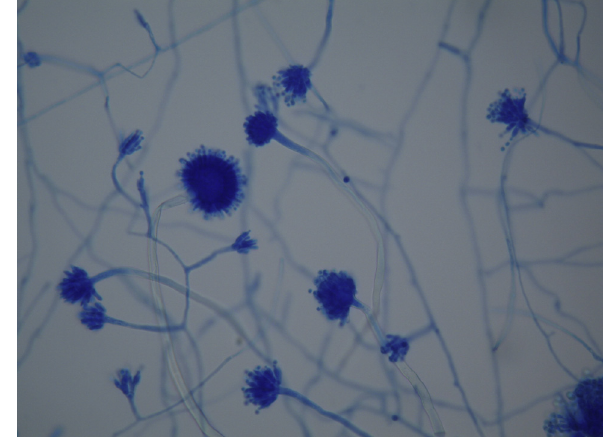
Aspergillus spp. --- image under optical